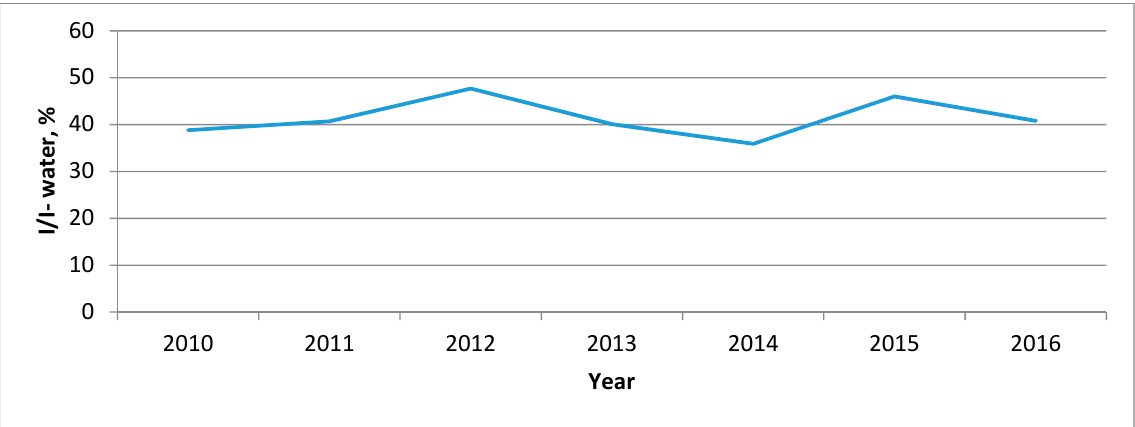
Figure 6. The development of I/I-water in Finland from 2010 to 2016 [26].